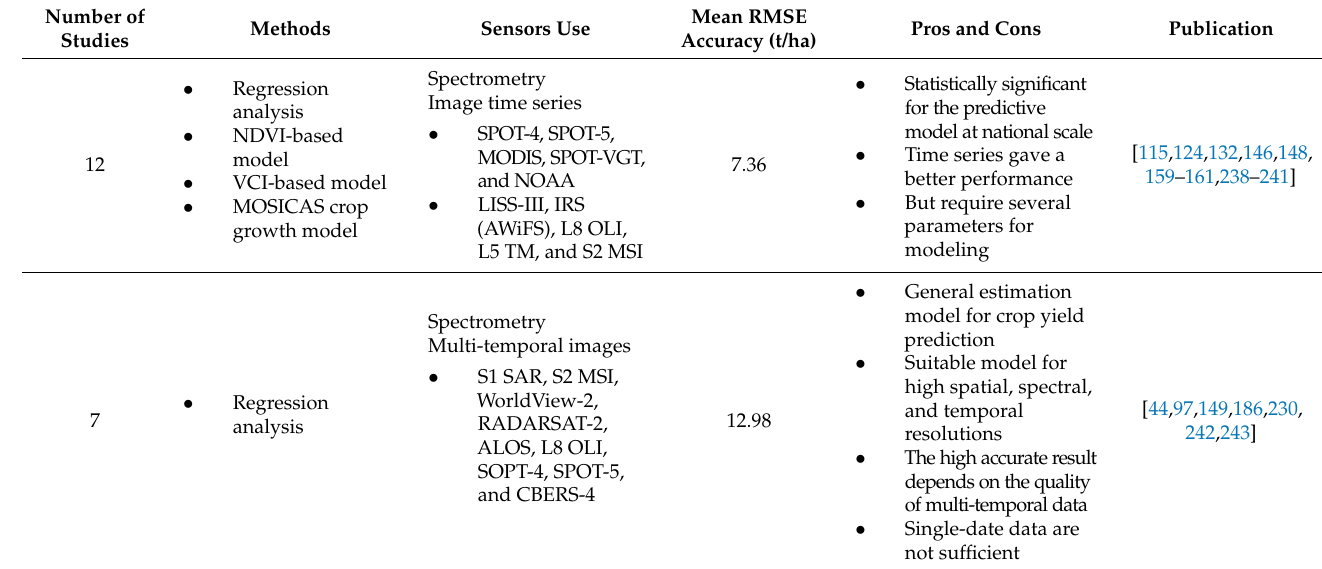
Table 6. Conclusion of previous studies, the methods, sensor data used, mean RMSE accuracy, and pros and cons for sugarcane yield